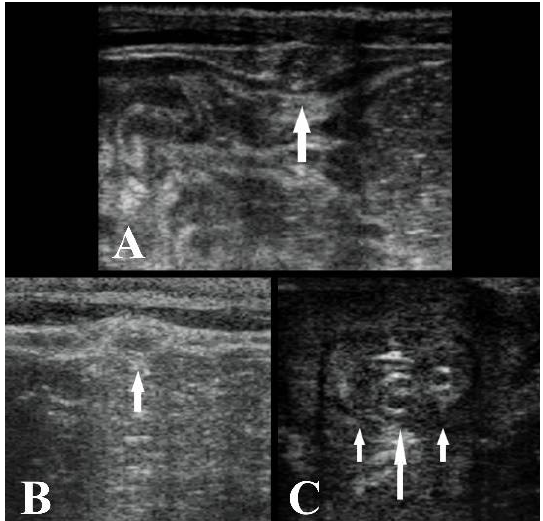
Figure 3. ( A ) Ultrasound image of the umbilical vein cranial to the umbilical stump at T2 (white arrow), transverse section. ( B ) Ultrasound image of the umbilical vein at the xiphoid cartilage at T2 (white arrow), transverse section. ( C ) Ultrasound image of the urachus (big white arrow) and left and right arteries (small white arrows) at T2, transverse section. The left side of the images is left, and the right side is right. B-mode, linear probe 7.5 MHz.